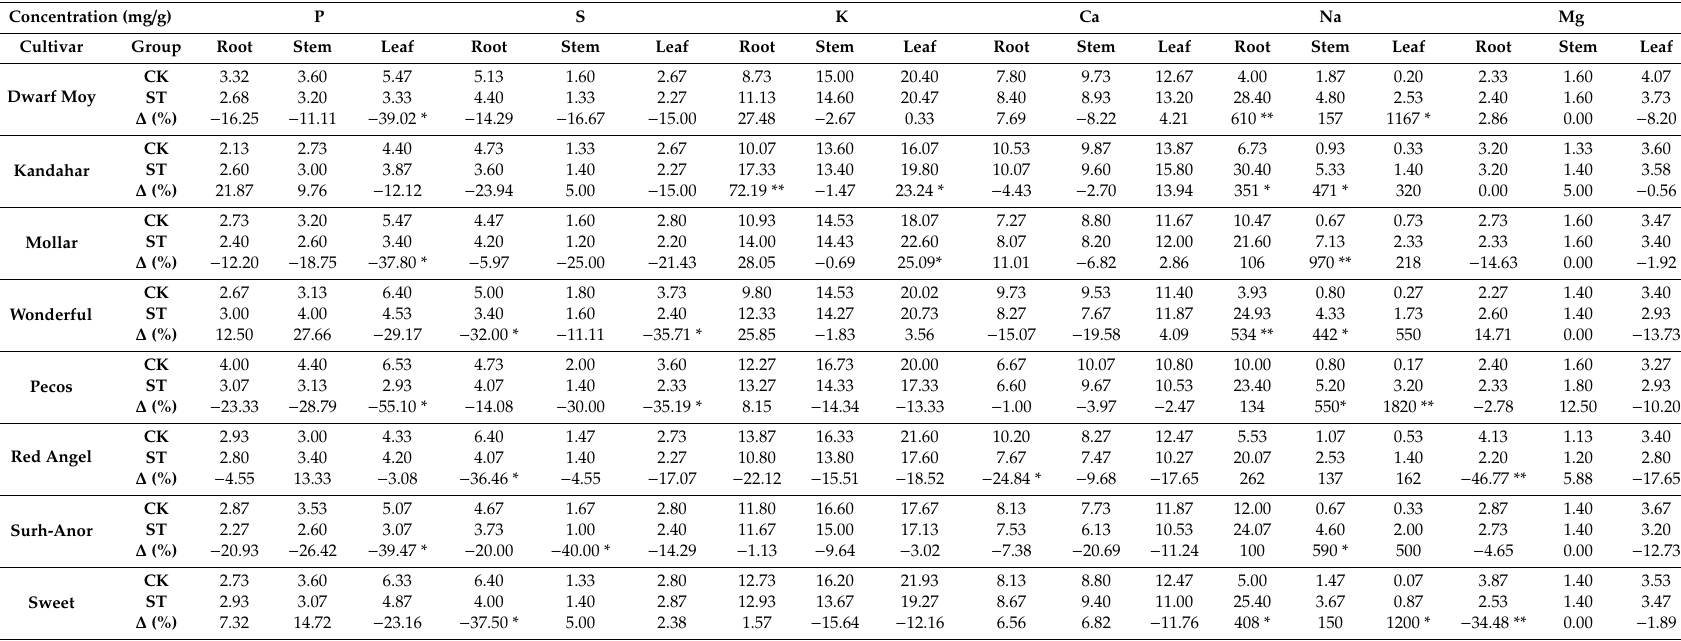
Table 5. The accumulation of macroelements in pomegranate roots, stems, and leaves under salt